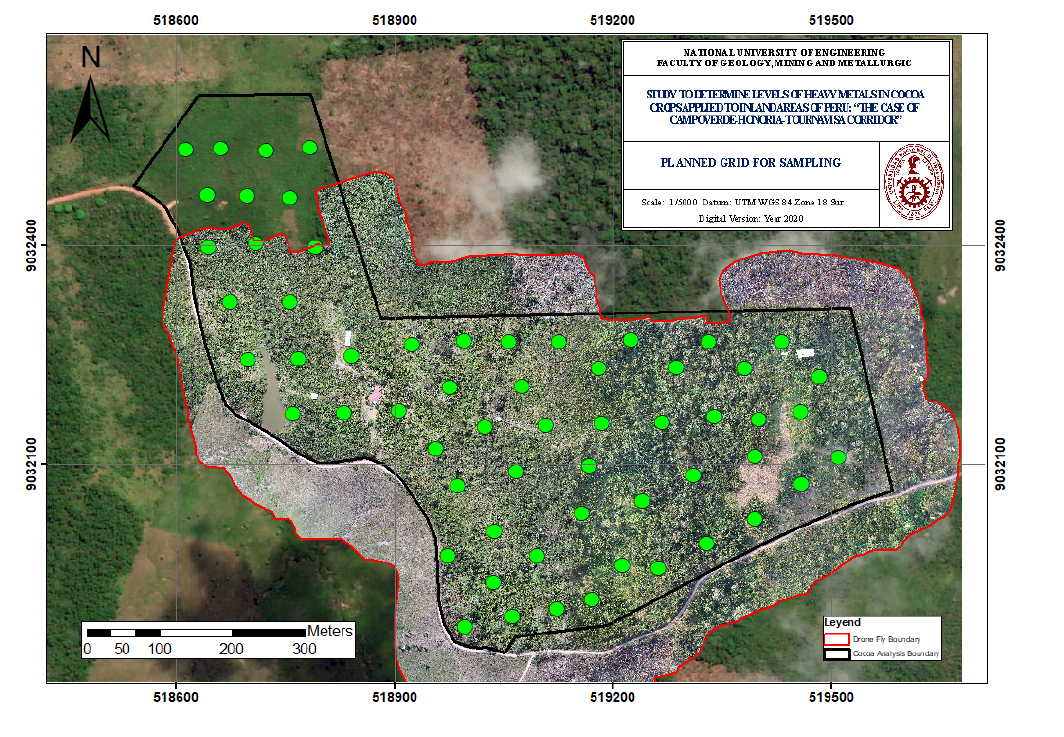
Figure 1. Delimitation of work